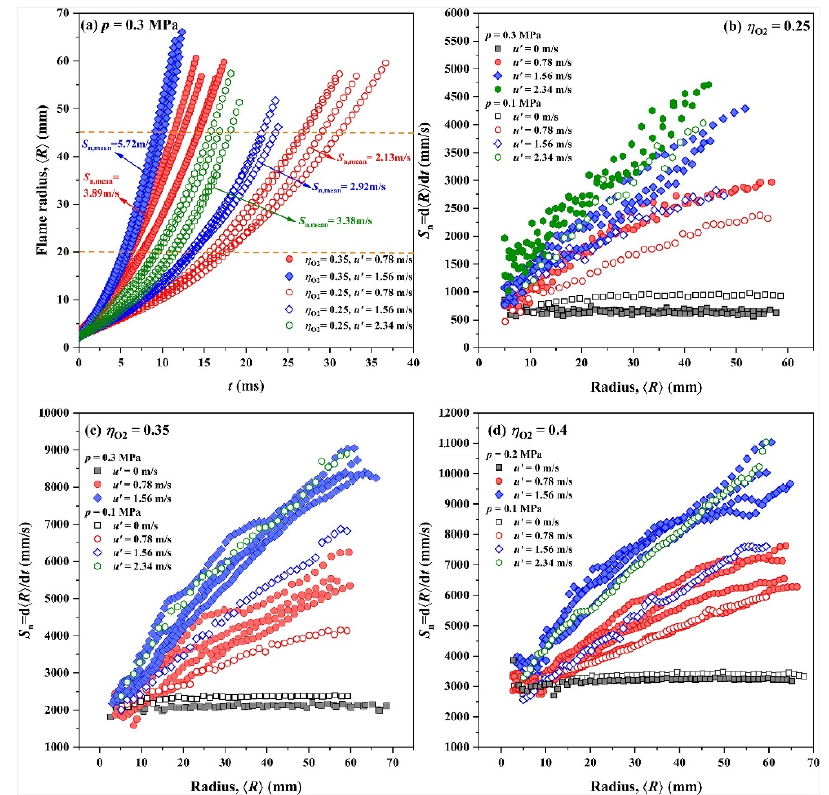
Figure 14. Flame radius verses time and turbulent flame speed against mean flame radius with increasing turbulent intensity, O 2 concentration and pressure at 298 K. Courtesy of Elsevier [83].